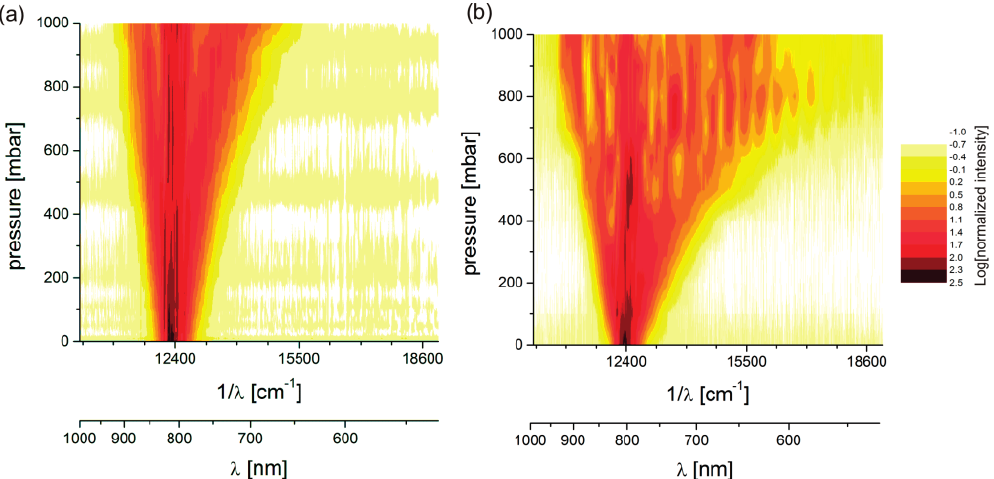
Figure 3. A comparison of spectral broadening in argon-filled ( a ) and SF 6 -filled ( b ) HCF for different gas pressures shows possible benefits for pulse-shaping experiments. For SF 6 the spectral broadening is larger than for argon for otherwise comparable conditions. The generation of Raman sidebands is observed by vertical lines with higher amplitude at fixed positions which corresponds to the A 1g vibrational mode. Both figures show the spectral intensity in a joint logarithmic color scale which is normalized to the output pulse energy of the